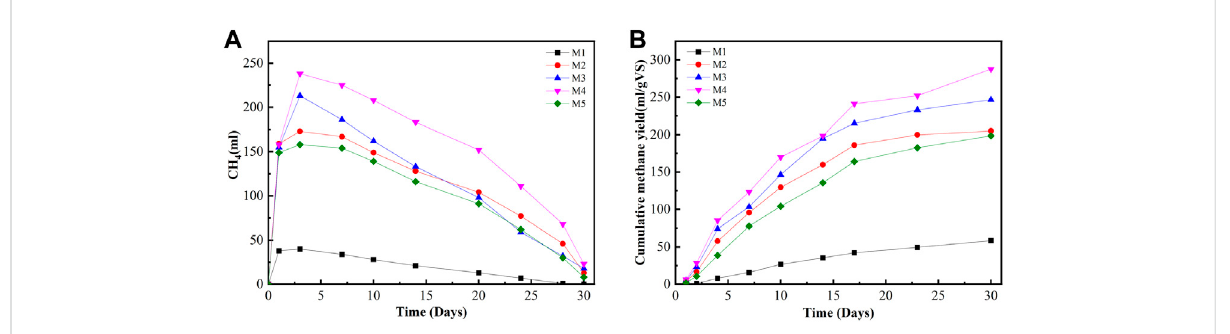
FIGURE 1 Daily methane production and cumulative methane production at different mixing ratios under mesophilic conditions. (A) Daily methane production. (B) Cumulative